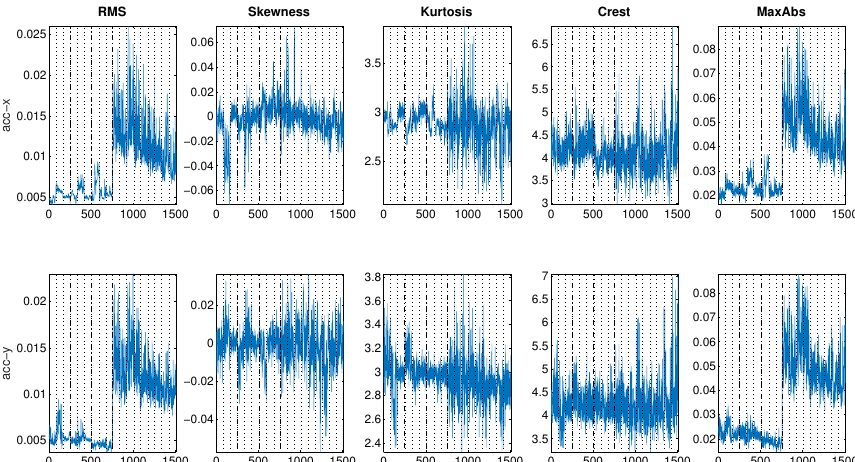
Figure 8. The statistical features computed on the cleaned data set. The different acquisitions are separated by the black dotted lines and ordered according to their corresponding TS number (Table 1). The healthy calibration data are separated from the healthy validation data, from the repaired validation data and from the damaged validation data by the black dash-dot